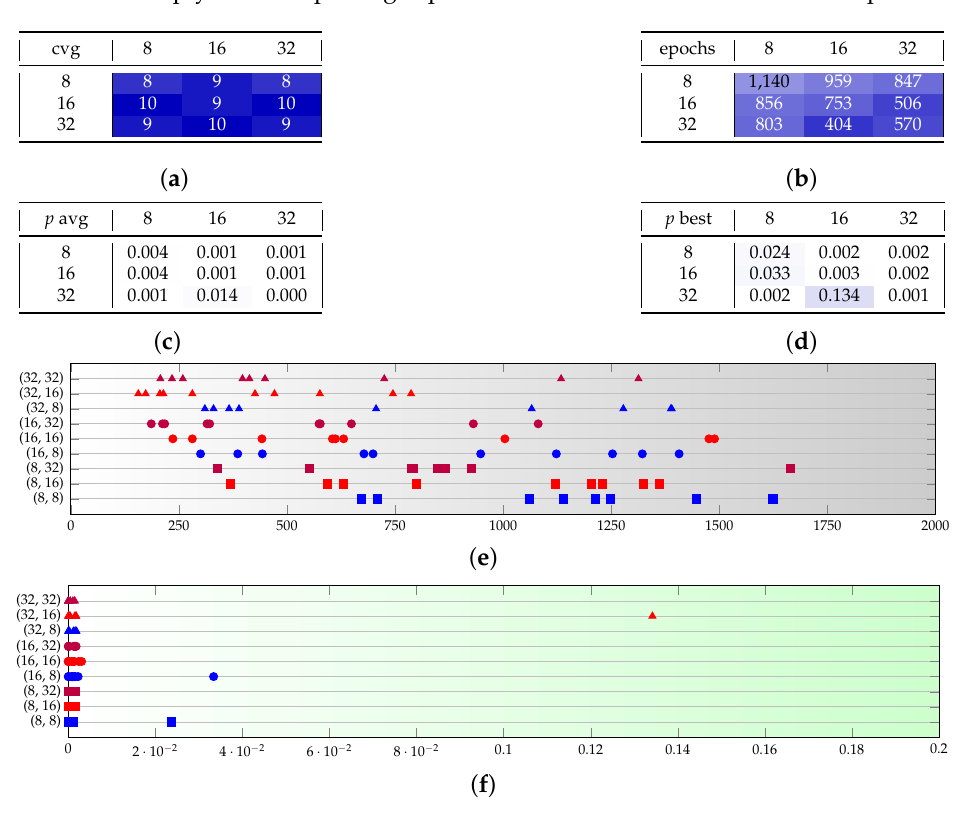
Figure A10. The test set I provides a sensitivity analysis on the number of shots s , with SPSA in the discriminator.